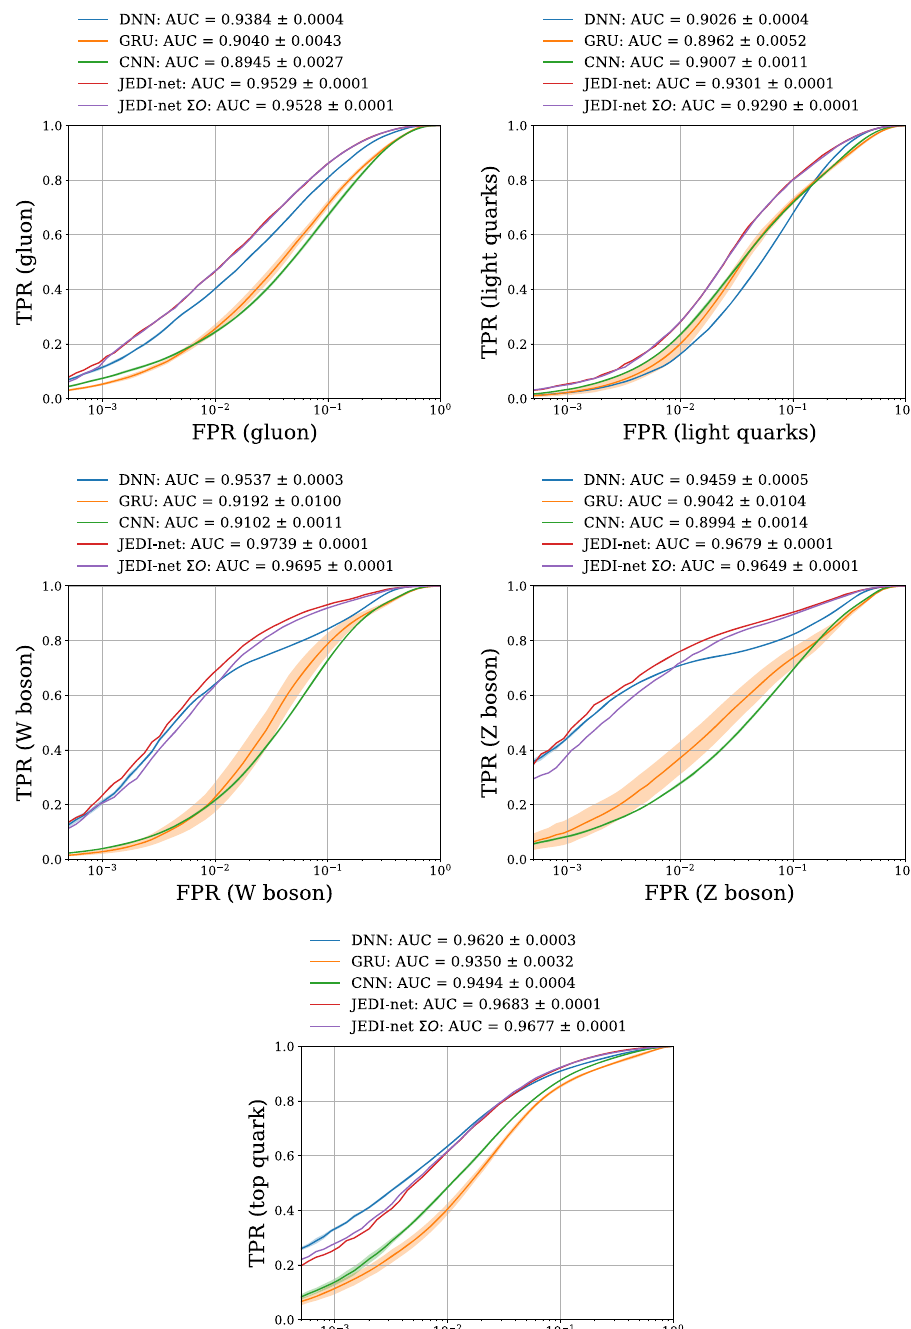
Fig. 8 ROC curves for JEDI-net and the three alternative models, computed for gluons (top-left), light quarks (top-right), W (center-left) and Z (center-right) bosons, and top quarks (bottom). The solid lines represent the average ROC curves derived from 10 k -fold trainings of each model. The shaded bands around the average lines are represent one standard deviation, computed with the same 10 k -fold